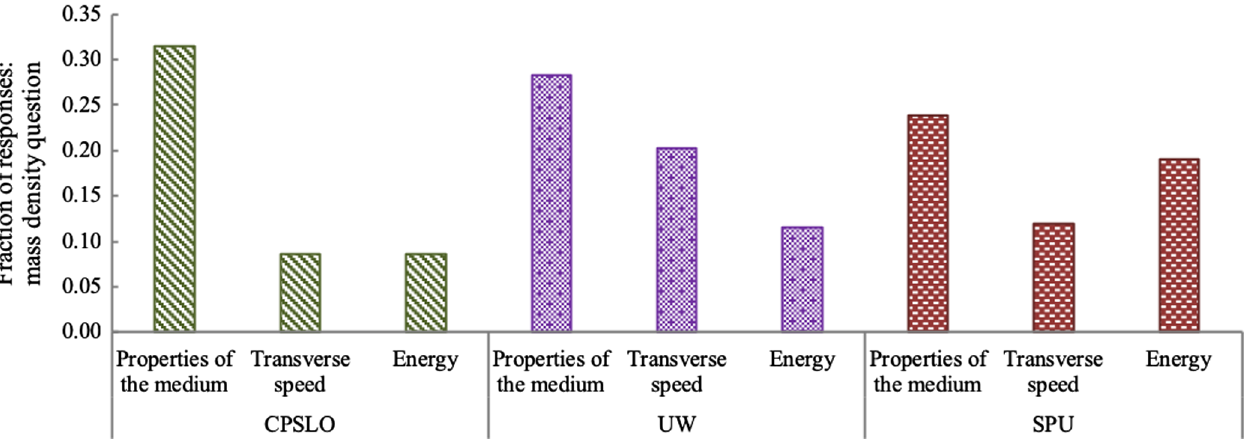
FIG. 5. Fraction of responses using three common resources for the mass density